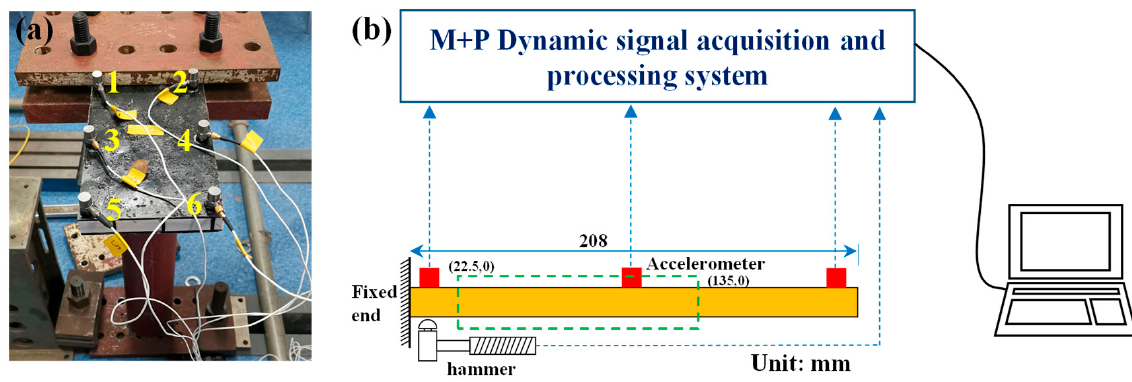
Figure 3. Schematic diagram of the modal experiment. ( a ) Clamped sample and measuring points (marked with number from 1 to 6) arrangement, and ( b ) schematic diagram of the experimental device. Considering the measured first-order and second-order natural frequencies (see Figure 4 below for specific values), the peak response of the first- and second-order natural frequencies f 0 was determined in the frequency response curve, and the frequencies f 1 and f 2 corresponding to 0.707 times the response peak were found. Then, the damping ratio ξ was calculated by the following Equation (1):